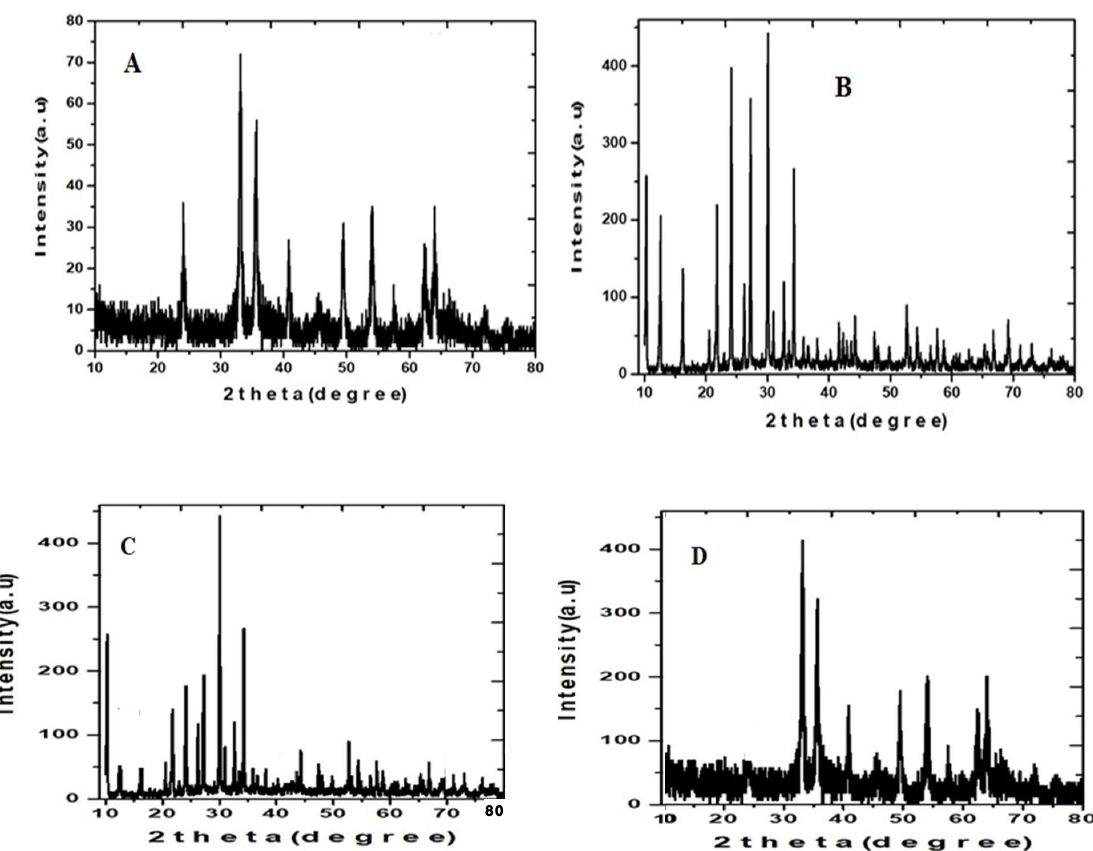
Figure 3. XRD images of synthesized silica nanoparticles for ( A ) barley husk, ( B ) barley grass, ( C ) barley, and ( D ) wheatgrass.